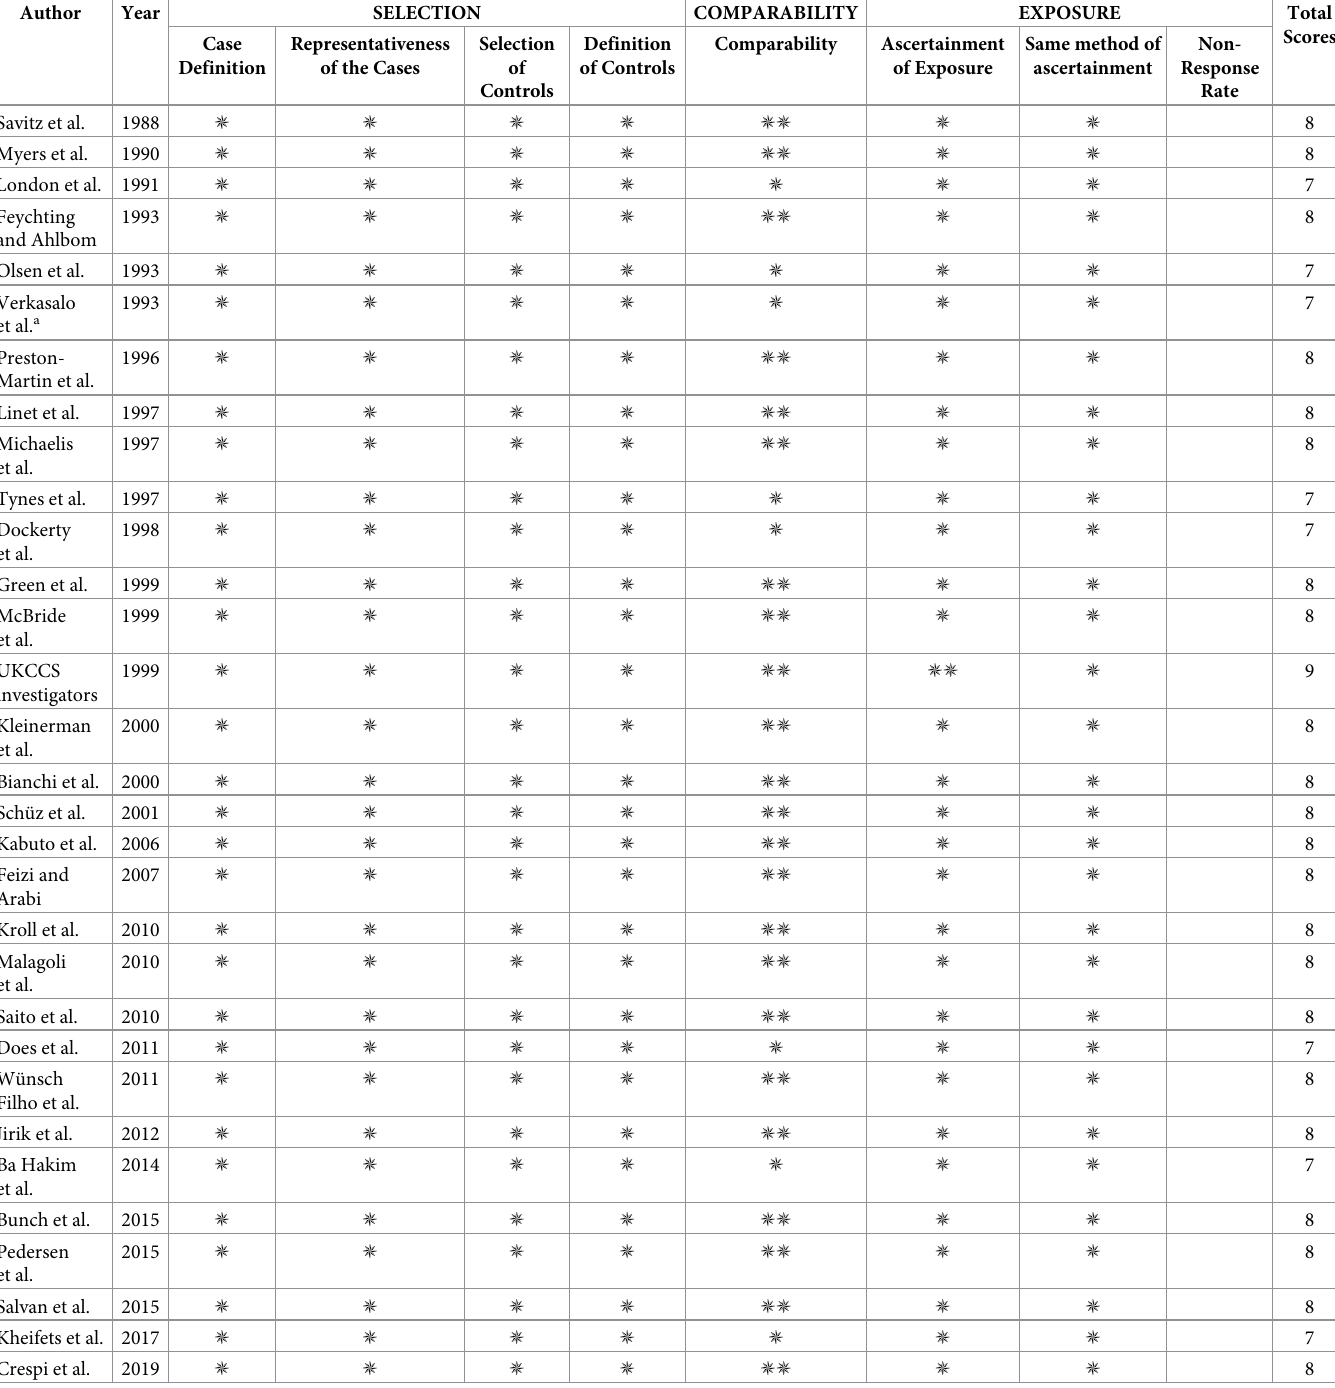
Table 3. Newcastle-Ottawa Scale assessment of the quality for the included